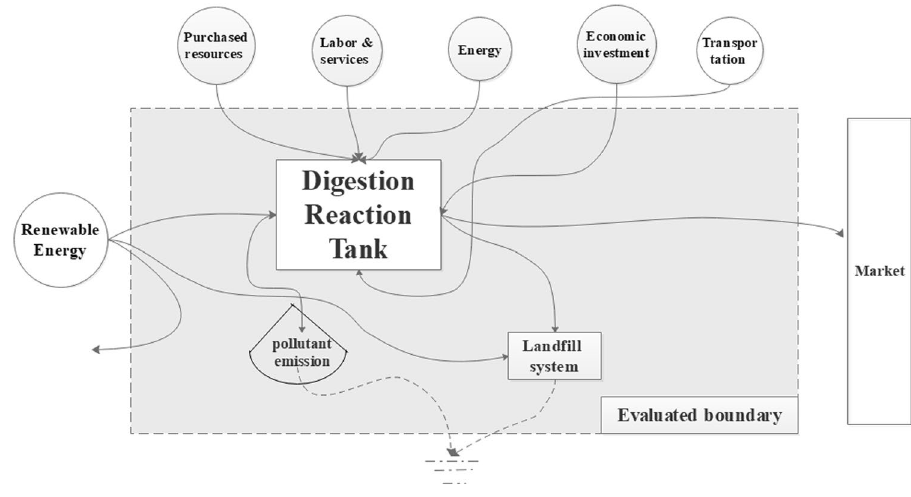
Fig. 4 Scenario B: the improved emergy flow of sewage sludge treatment